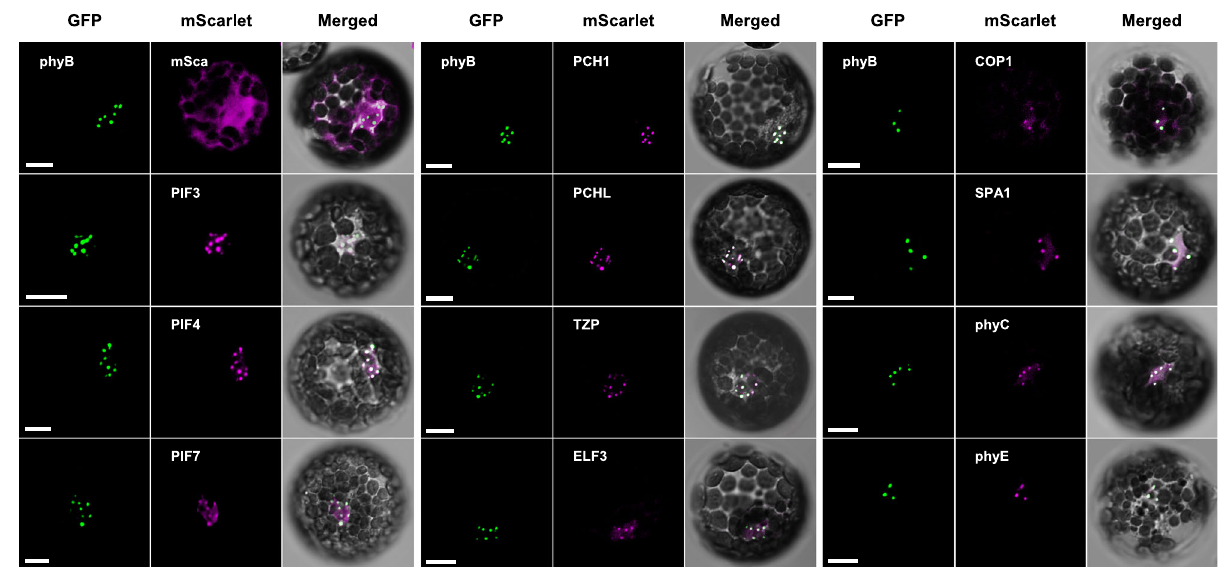
Fig. 3 | PhyB photobody components that readily localize to the phyB photo- body. mScarlet-fusedcandidateproteinsweretransientlyexpressedinprotoplasts prepared from PHYB-GFP transgenic plants. Images were taken under confocal microscopy using the GFP channel (488nm-525/25nm) for phyB-GFP (GFP, green color) and the RFP channel (561nm-595/25nm) for mScarlet-fused proteins (mScarlet, magenta color). The fl uorescence images were merged with white light images (Merged). Non-fused mScarlet (mSca) was used as a control protein and